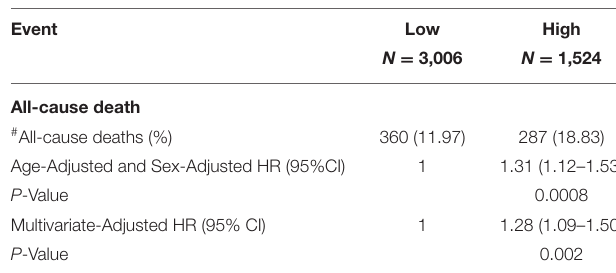
TABLE 3 | Prediction performance of ECG abnormality score (low EA and high EA) associated with all-cause death ( N = 4,530). Event